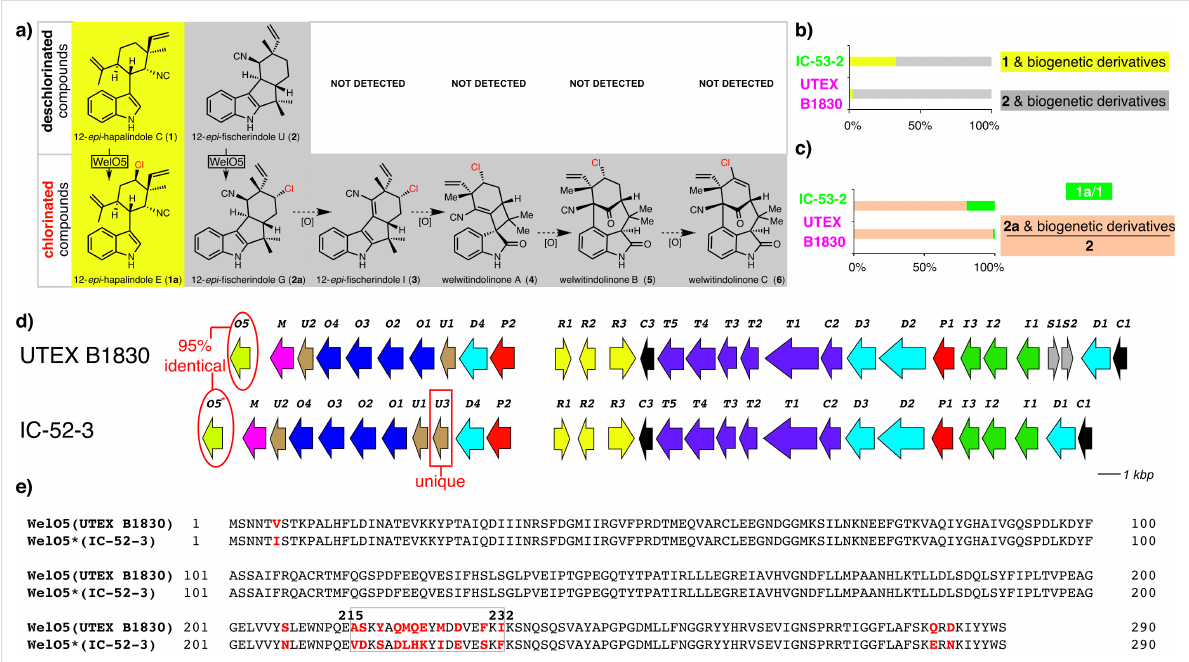
Figure 1: Comparative analysis of hapalindole-type alkaloids and their BGCs in two welwitindolinone producers implicates the functional role of Fe/2OG-dependent WelO5* halogenase in structural diversifications in H. welwitschii IC-52-3. a) Representative hapalindole-type alkaloids tabulated based on oxidation states in the welwitindolinone producers H. welwitschii UTEX B1830 and IC-52-3. b) Relative quantities of 1 and its biogenetic de- rivative 1a versus 2 and its biogenetic derivatives ( 2a , 3 – 6 ) in H. welwitschii IC-52-3 and UTEX B1830. c) Comparison of the ratio of chlorinated versus dechlorinated hapalindole-type alkaloids based on their biosynthetic origins (i.e., 1 or 2 ) in H. welwitschii IC-52-3 and UTEX B1830. d) Com- parison of welwitindolinone BGCs in H. welwitschii IC-52-3 and UTEX B1830. The tailoring enzyme coding genes, including wel U1-3, wel O1-5 and wel M, encoded in the welwitindolinone BGC from H. welwitschii IC-52-3, were renamed due to their extreme similarities to those from H. welwitschii UTEX B1830. e) Sequence comparison of WelO5 and WelO5*. Varied residues are highlighted in red with the most aggregated region 215-232 in grey